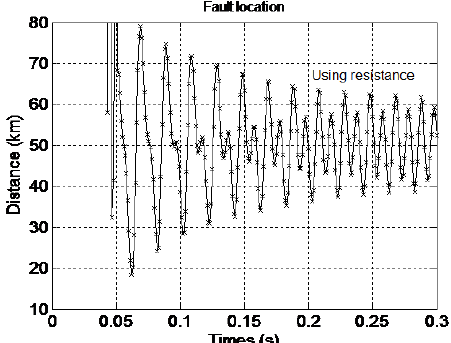
Fig. 5: Fault location as function of time using the re- sistance.